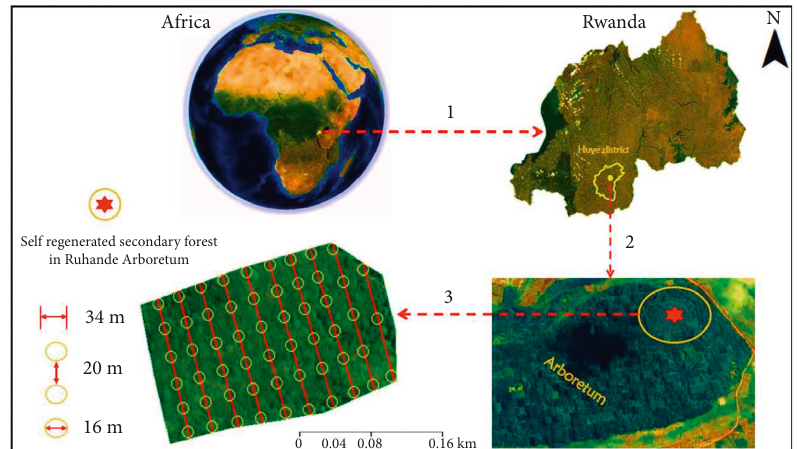
Figure 1: Map of the study area in the self-regenerated secondary forest in Ruhande Arboretum, Huye,